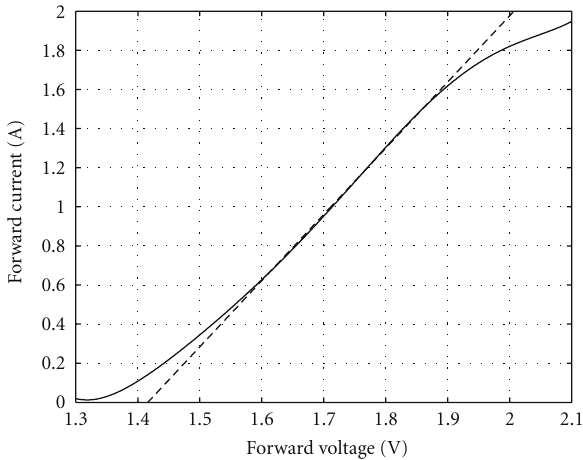
Figure 6: The LED transfer characteristics of the OSRAM, SFH 4230 showing the forward voltage and forward current relation. The dashed line shows the function that corresponds to the linear region of the LED transfer response.